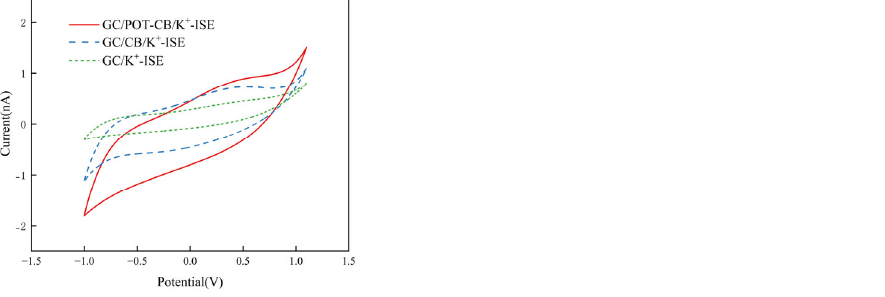
Figure 2. Cyclic Volt–Ampere curve of GC/POT − CB/K + − ISE, GC/CB/K + − ISE, GC/K + −